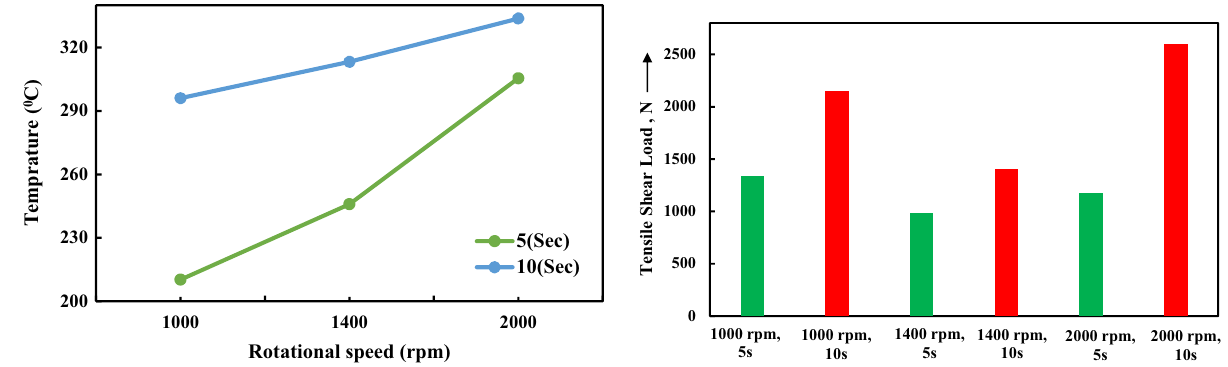
Figure 3: Temperature evaluation of Al7075 - T651/Ti - 6Al - 4V alloy at di ff erent rotational speeds and dwell times.